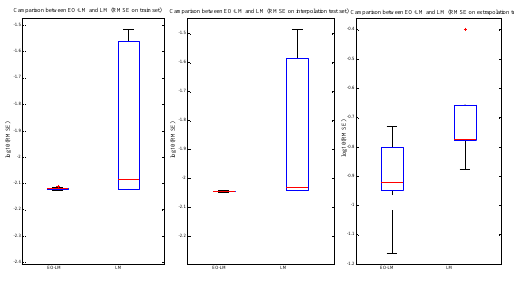
Fig. 3. The comparison of RMSE distribution between EO-LM and LM on train/ interpolation test/ extrapolation test set